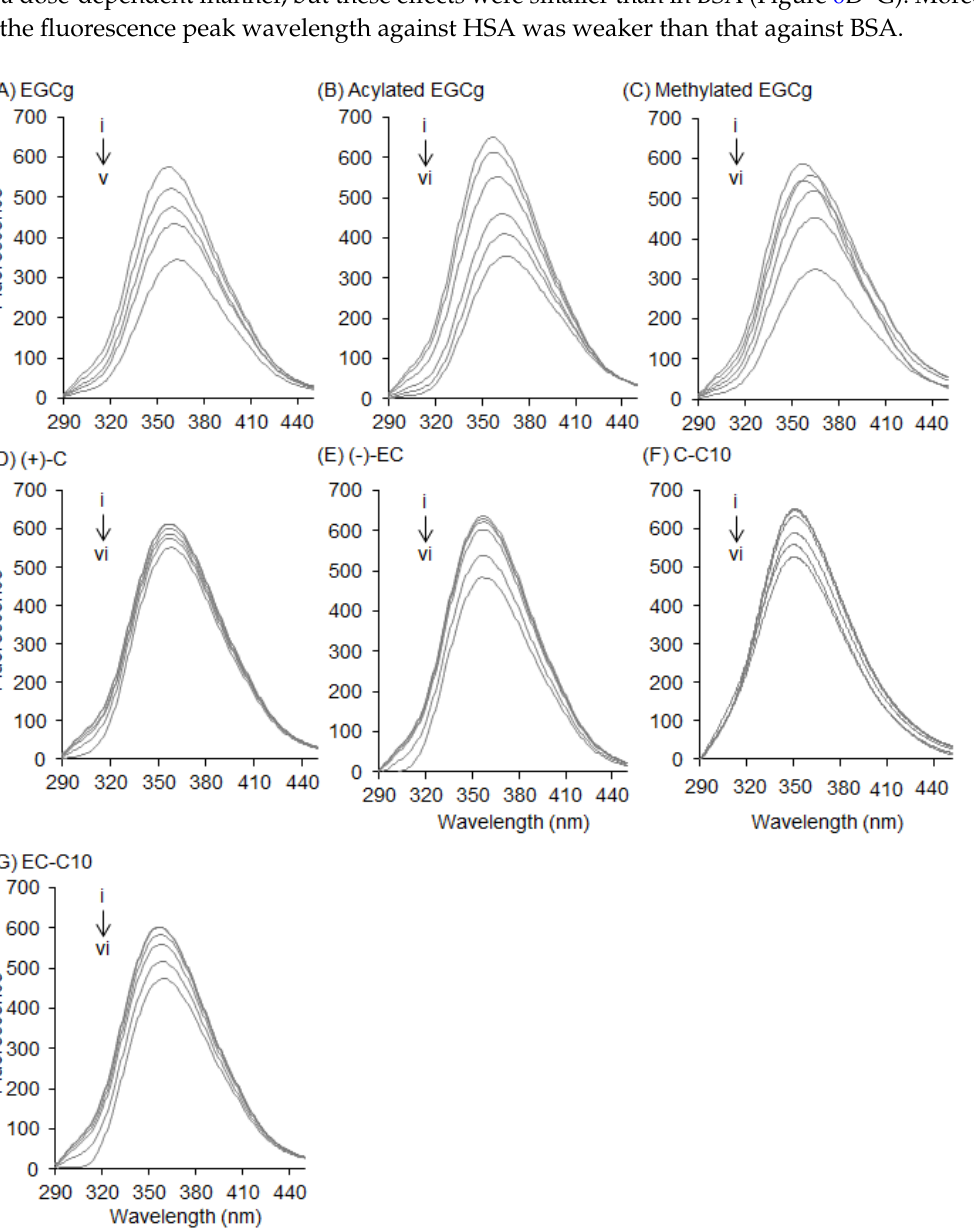
Figure 6. Effects of catechins and their derivatives on the fluorescence of human serum albumin (HSA). Fluorescence spectra of 0.3 mg/mL HSA with various concentrations of ( A ) EGCg; ( B ) acyl-EGCg; ( C ) methyl-EGCg; ( D ) (+)-C; ( E ) ( − )-EC; ( F ) C-C10; and ( G ) EC-C10 were measured at an excitation wavelength of 280 nm. Symbols i to vi show the spectra of HSA with increasing quencher concentrations of 0, 1, 5, 12.5, 25, and 50 µ M, respectively.